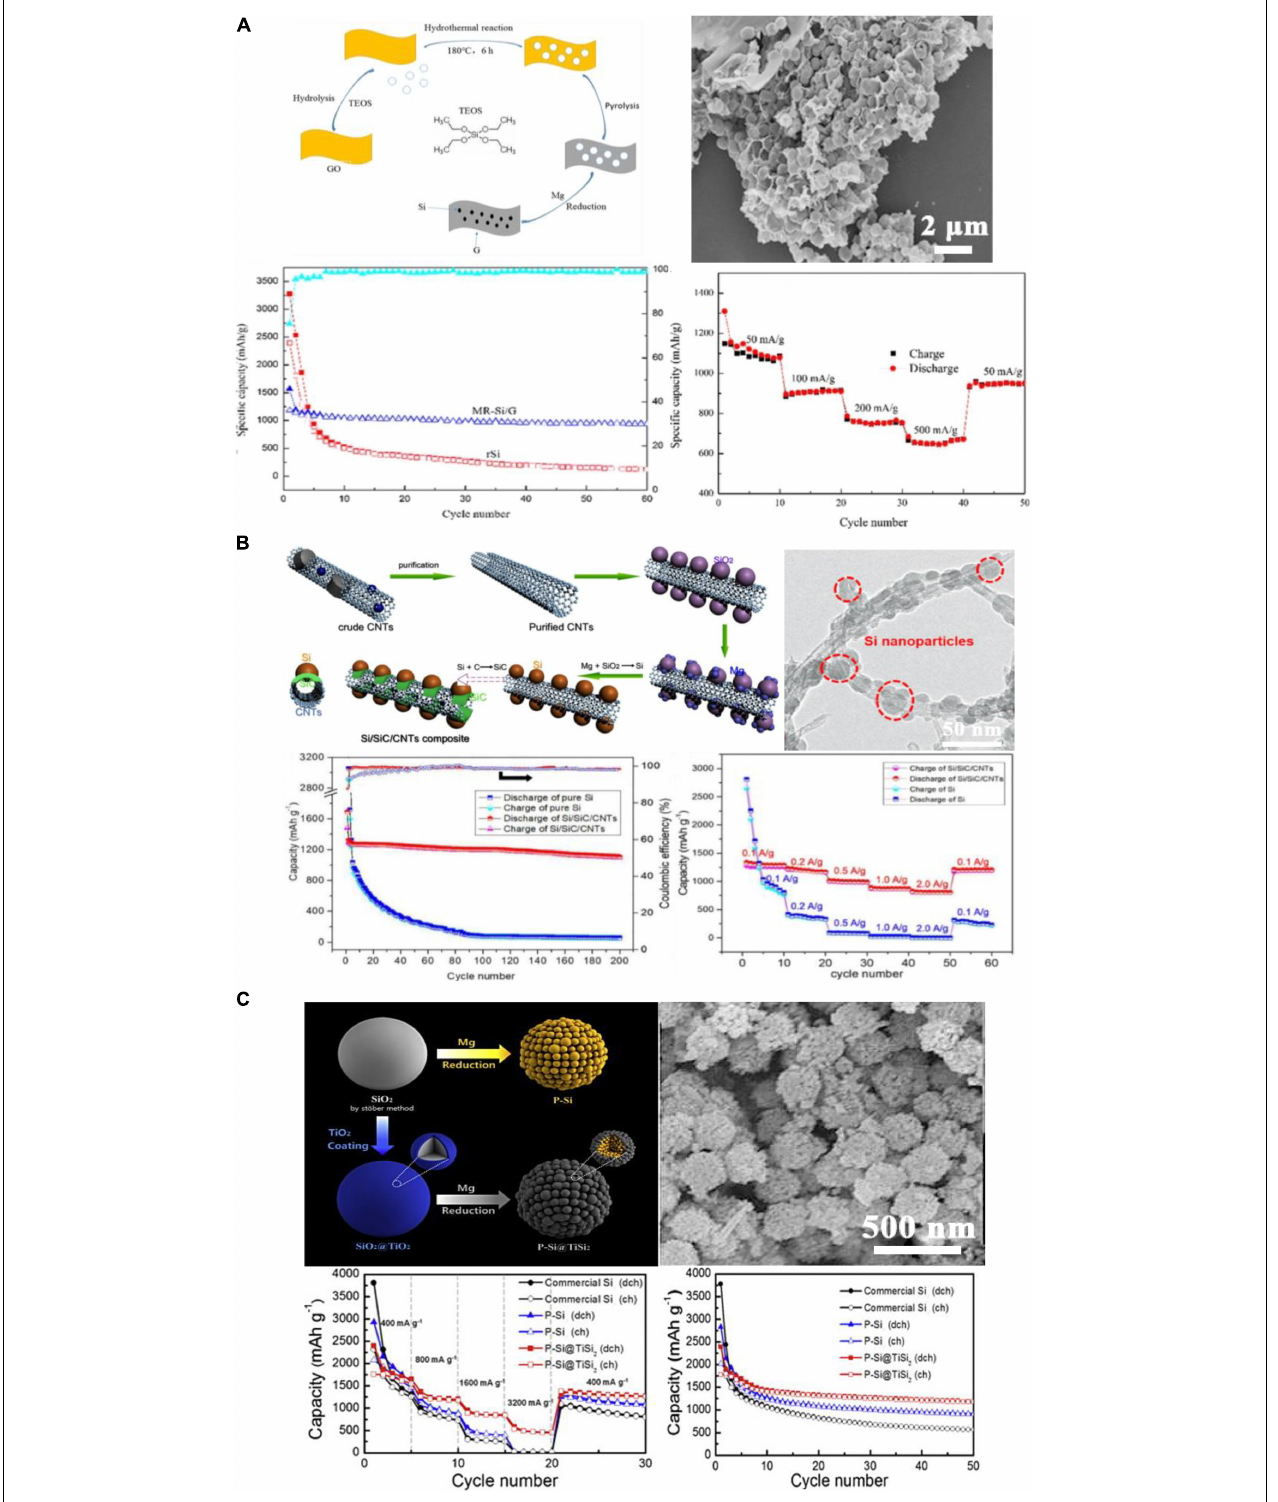
FIGURE 9 | (A) Schematic diagram of preparation, SEM, cycling and rate performance of Si/G reduced from SiO 2 /GO. Reprinted from Ref. (Zhu et al., 2017), with the permission of Springer Nature. (B) Fabrication schematic diagram, TEM and electrochemical performance Si/CNTs reduced from SiO 2 /CNTs. Reprinted from Ref. (Zhang et al., 2019), with the permission of MDPI. (C) Schematic, SEM, and rate performance of Si/TiSi 2 spheres. Reprinted from Ref. (Kim Y.M. et al., 2015), with the permission of Elsevier.